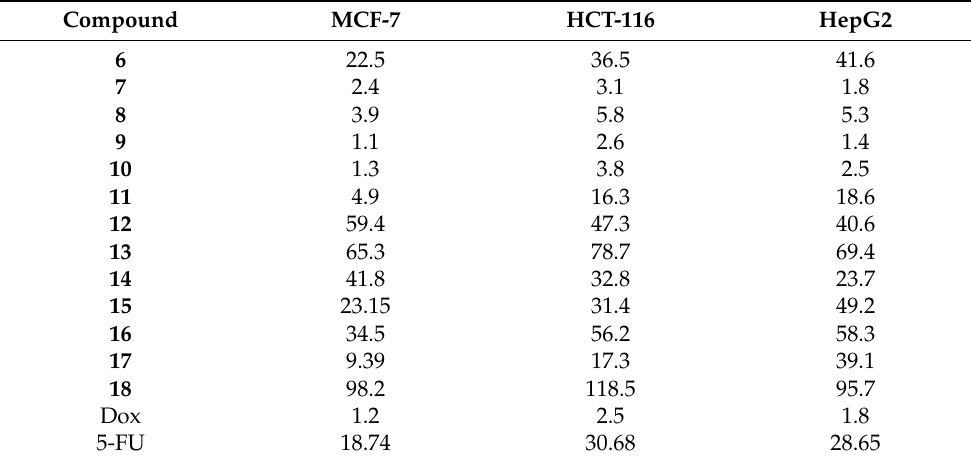
Table 2. Cytotoxicity (IC 50 ± SD, µ M) of the final derivatives against MCF-7, HCT-116, and HepG2 cell lines.